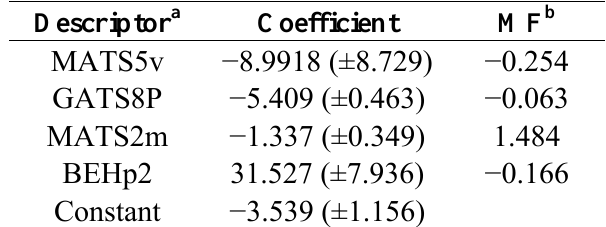
Table 11. Details of the constructed MLR model.